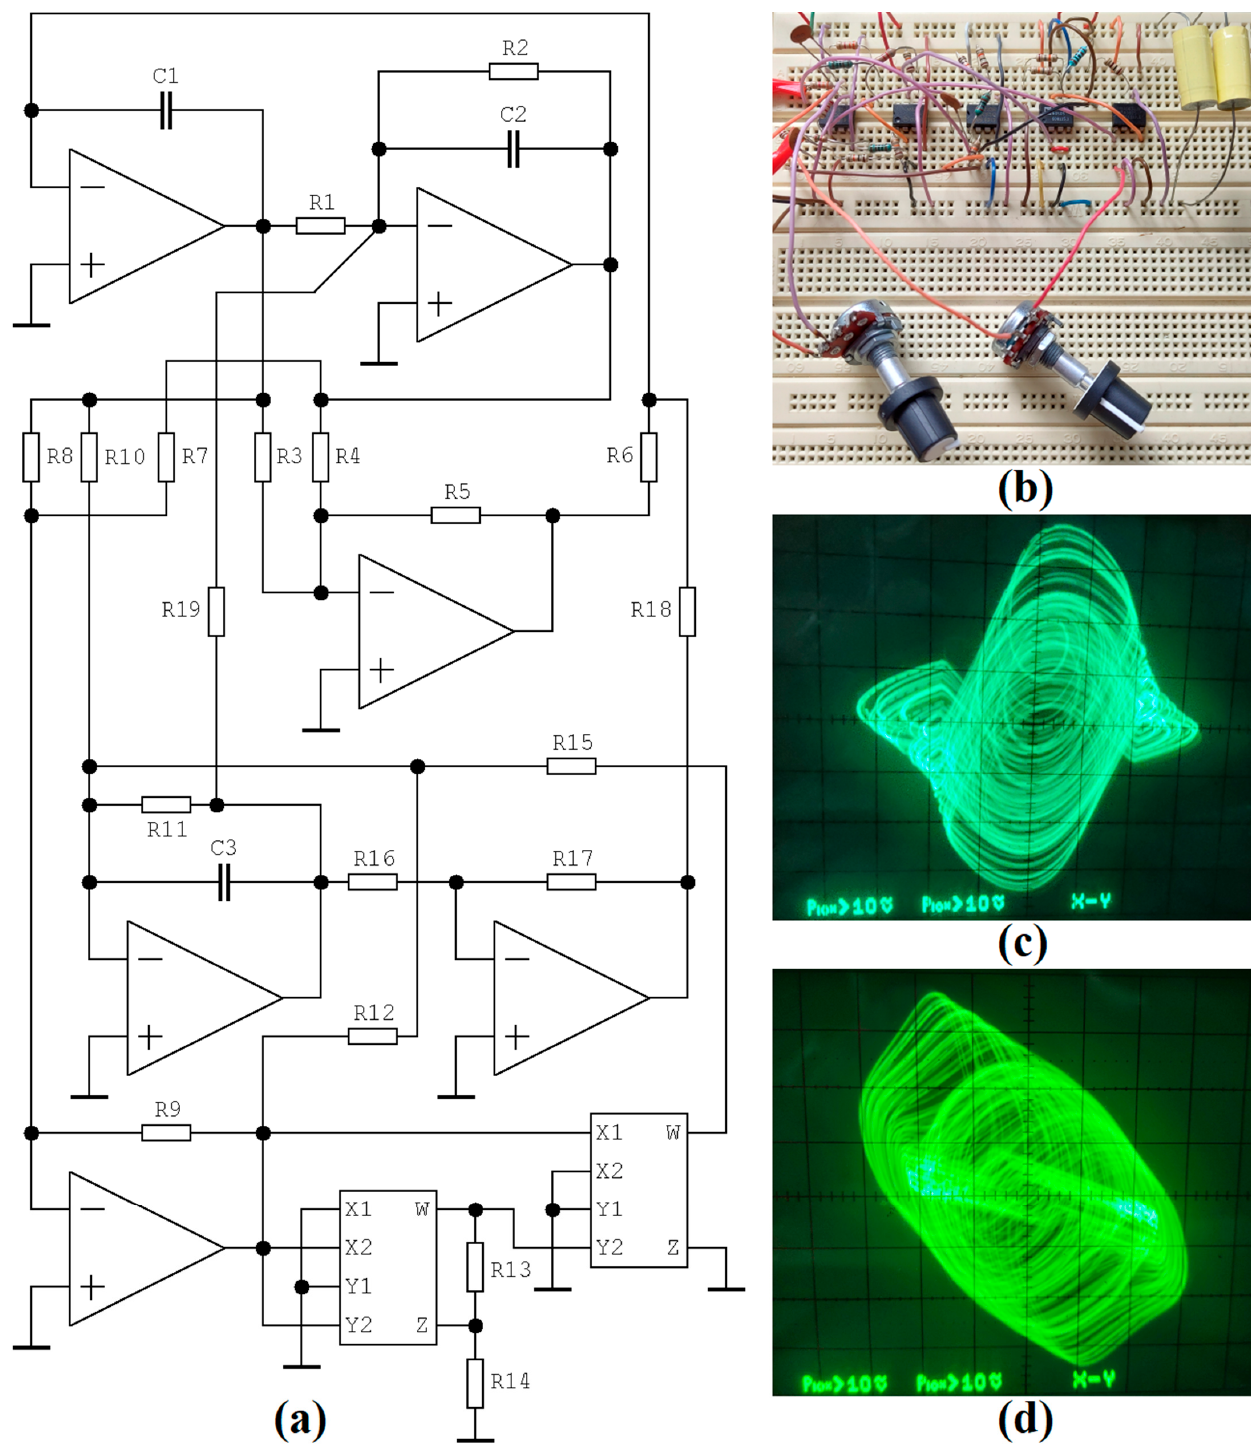
Figure 3. Pieces of experimental verification: ( a ) circuitry implementation of chaotic oscillator, design based on the analog computer concept, ( b ) breadboard realization with two adjustable parameters ( R 2 , R 15 ) via potentiometers, ( c ) strange attractor visualized in plane projection v 3 – v 1 , ( d ) plane projection v 3 – v 2 .